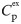
DSC profiles for BSA (1 mg/ml) preheated at 60°C (0.1 M Na-phosphate buffer, pH 7.0).The dependences of the excess heat capacity (ΔCpex) on temperature for BSA preincubated at 60°C for different time intervals (tinc): (1) 0, (2) 5, (3) 15, (4) 30, (5) 60 and (6) 90 min. Each DSC profile is the average of three measurements. The heating rate was 1°C/min. The inserted table gives the value of Tmax for preheated BSA preparations.